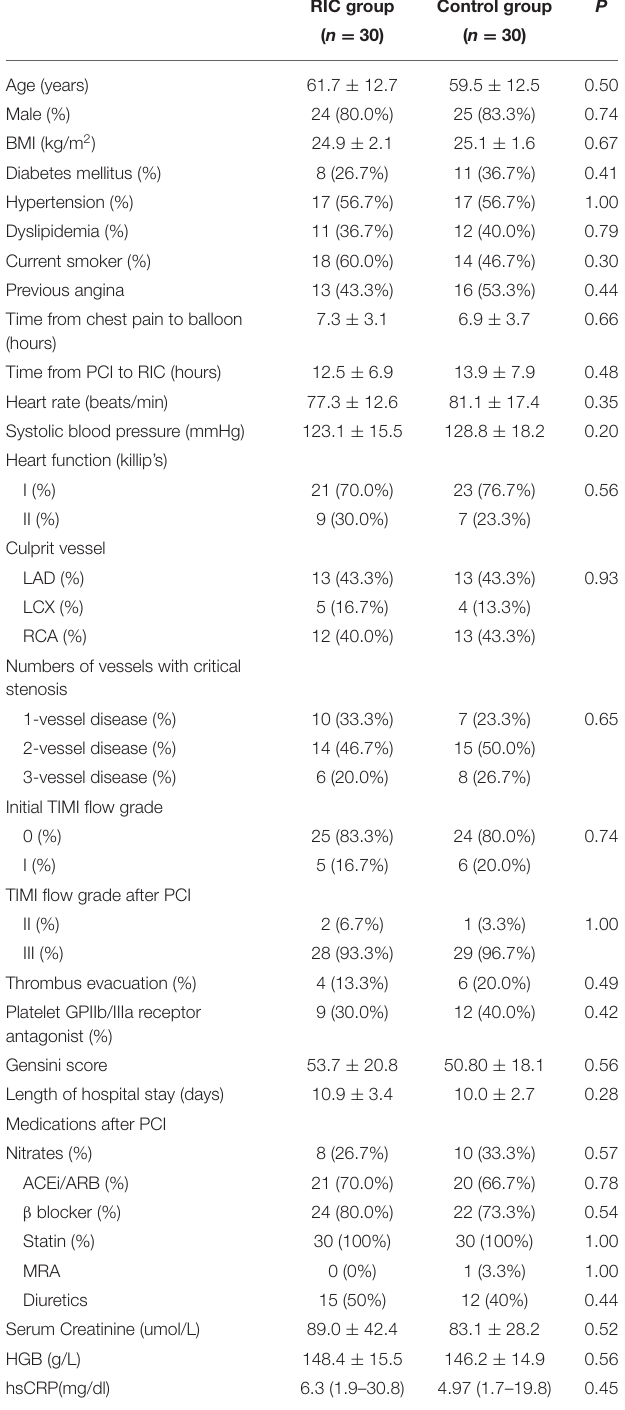
Data are expressed as a mean ± SD, median (25th, 75th percentiles), or number (percentage). ACEi, ACE inhibitor; ARB, angiotensin receptor blocker; BMI, body mass index; GP, Glycoprotein; hsCRP, high-sensitivity C-reaction protein; HGB, hemoglobin; LAD, left anterior descending artery; LCX, left circumflex artery; MRA, mineralocorticoid receptorantagonist;PCI,percutaneouscoronaryintervention;RCA,rightcoronaryartery; RIC, remote ischemic conditioning; TIMI, thrombolysis in myocardial